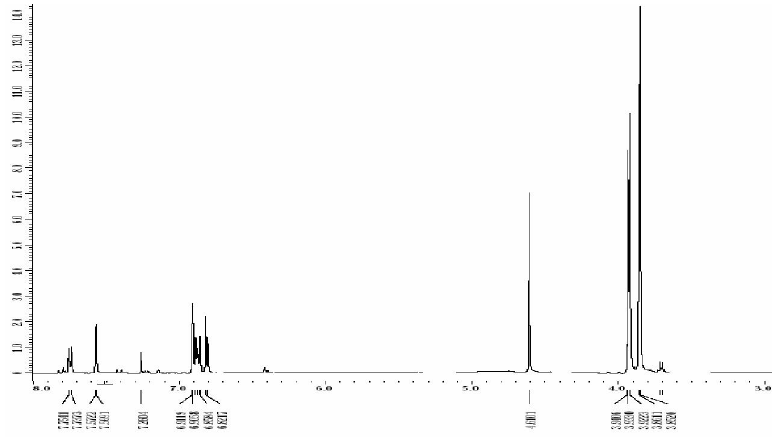
Figure 4. 1 H NMR Spectrum of 2',4'-dihydroxy 3,4-dimethoxy chalcone